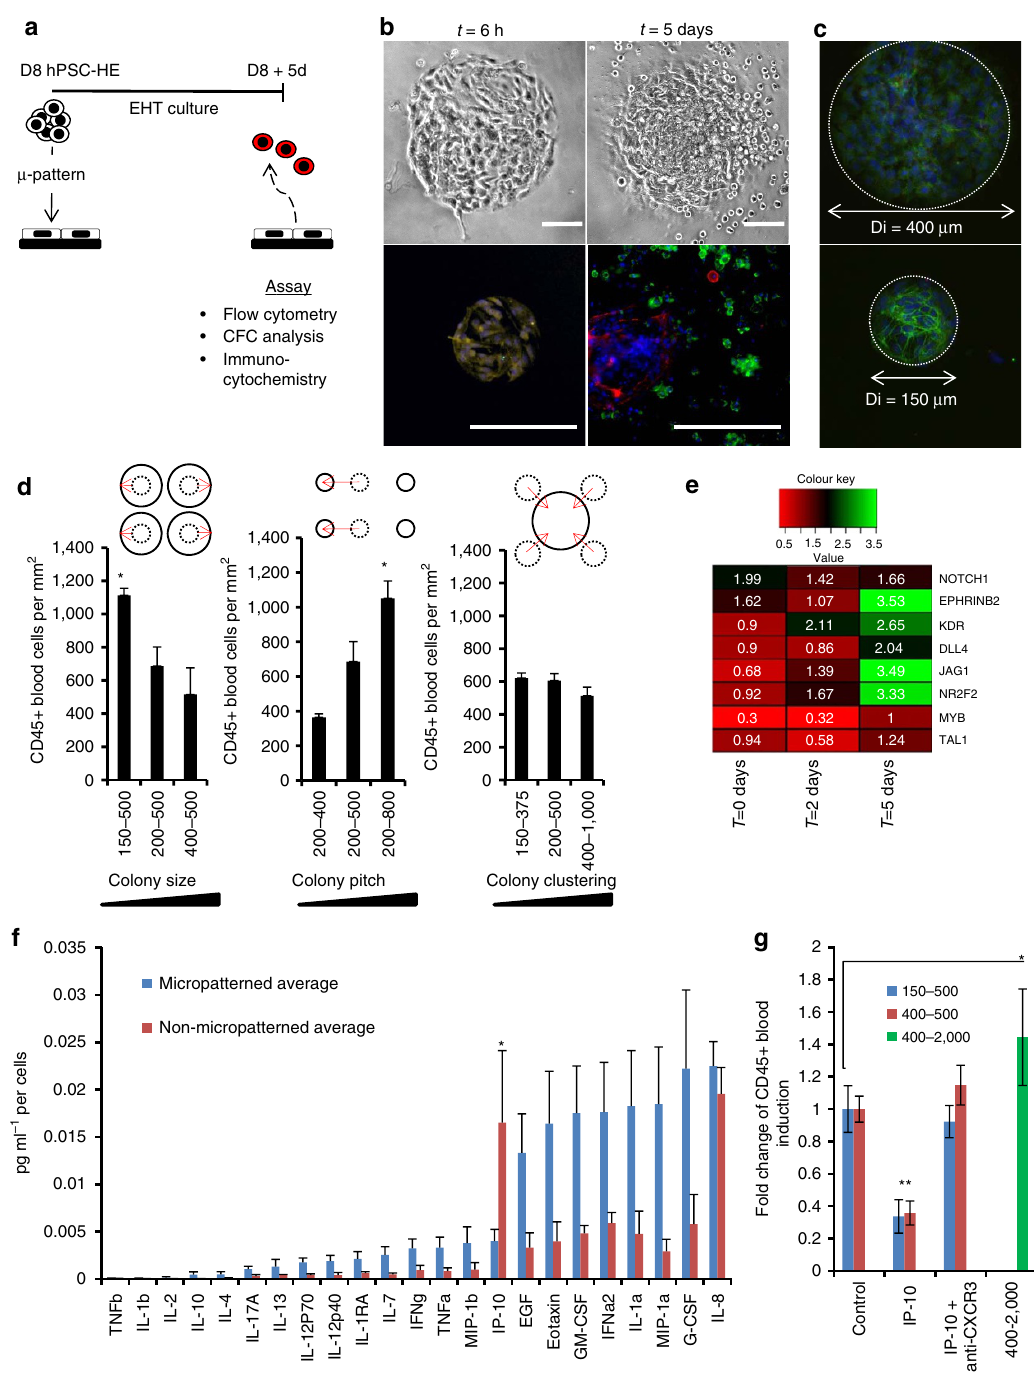
Figure 3 | Spatial control of day 8 hPSC-derived HE via micropatterning enhances CD45 þ generation in the 150–500 condition during haematopoietic differentiation. ( a ) Schematic of EHT culture and assessment of cells at assay end point. Micropatterns are depicted as diameter–pitch (diameter: diameter of colony/pitch: distance between colony centres; for example, 150–500). ( b ) Micropatterned day 8 prospective HE colonies cultured